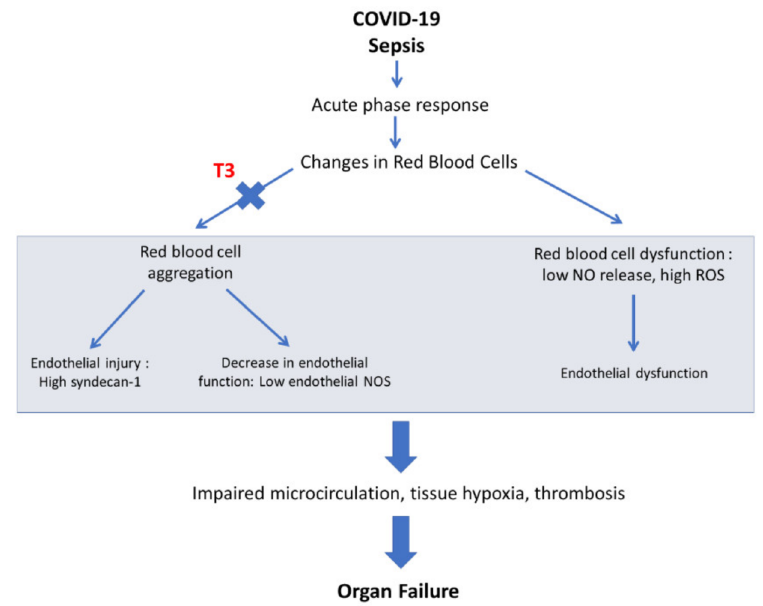
Figure 1. Schematic of the potential role of erythrocyte in COVID-19 vasculopathy and the potential effect of T3 in this response. T3: triiodothyronine, ROS: reactive oxygen species, NO: nitric oxide, NOS: NO